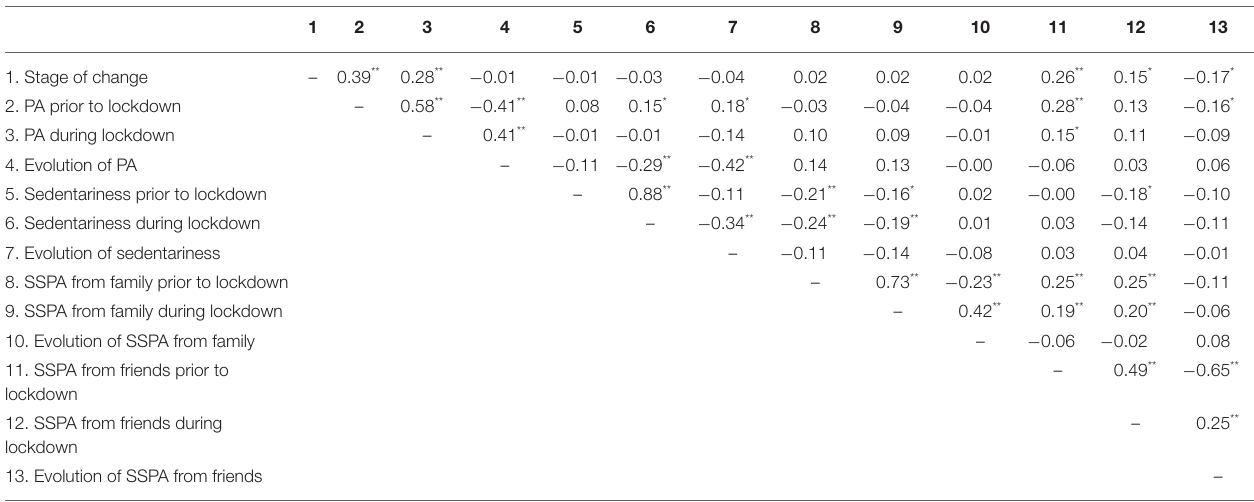
TABLE 4 | Bivariate Correlations for Workers ( n =